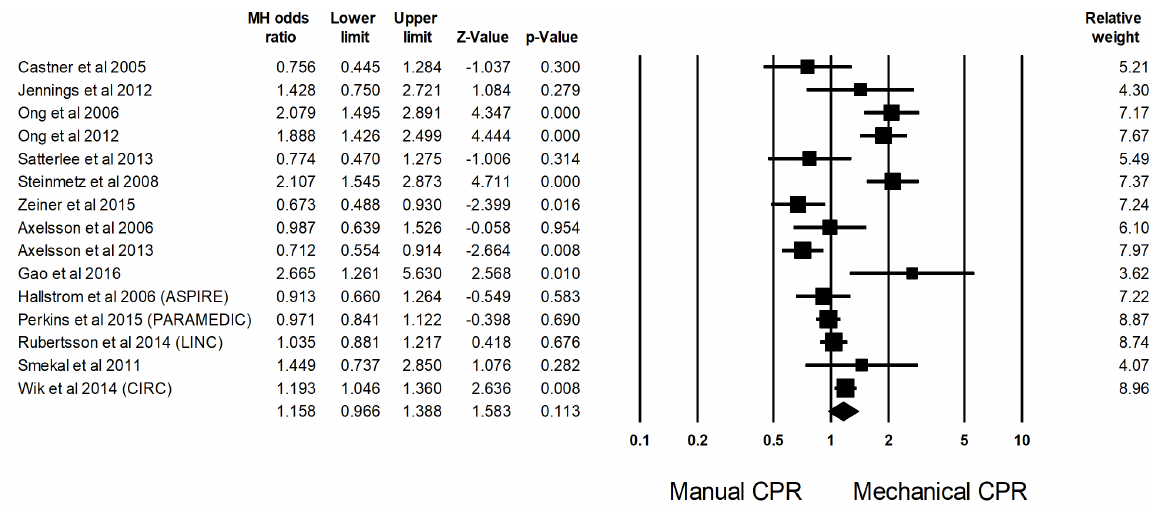
Figure 2. Forest plot for meta-analysis comparing manual vs mechanical cardiopulmonary resuscitation. Heterogeneity: Tau 2 =9.1%, SE= 0.056, I 2 =83.079%, df=14 (p=0.00),Q=82.74 ROSC , return of spontaneous